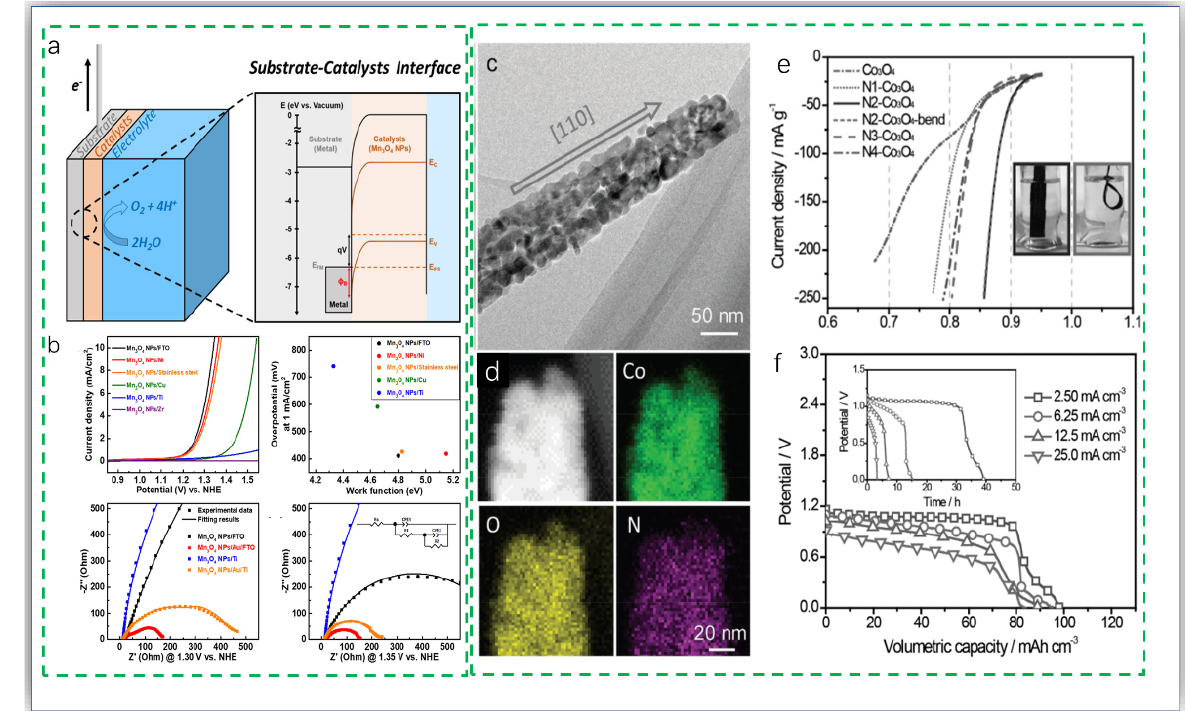
Figure 6. Enhanced conductivity by tuning the band structure and surface nanoengineering. (a) Mn 3 O 4 band structure diagram [74], (b) Electrochemical activity diagrams of different Mn 3 O 4 -based ety. (c) TEM image of N-Co 3 O 4 [80], (d) EDS mapping of N-Co 3 O 4 [80], (e) IR-corrected polarization